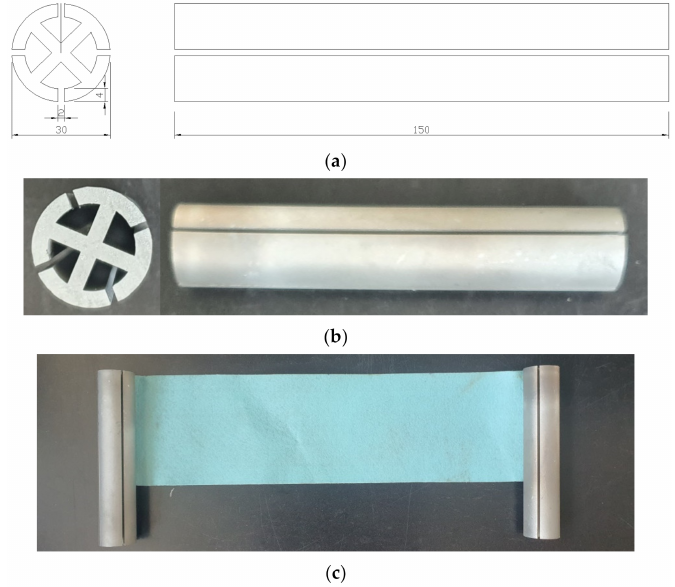
Figure 10. Reduced model of RSIM: ( a ) design dimensions (unit: mm), ( b ) actual production, and ( c ) combination of the supporting pile and the smart liner.